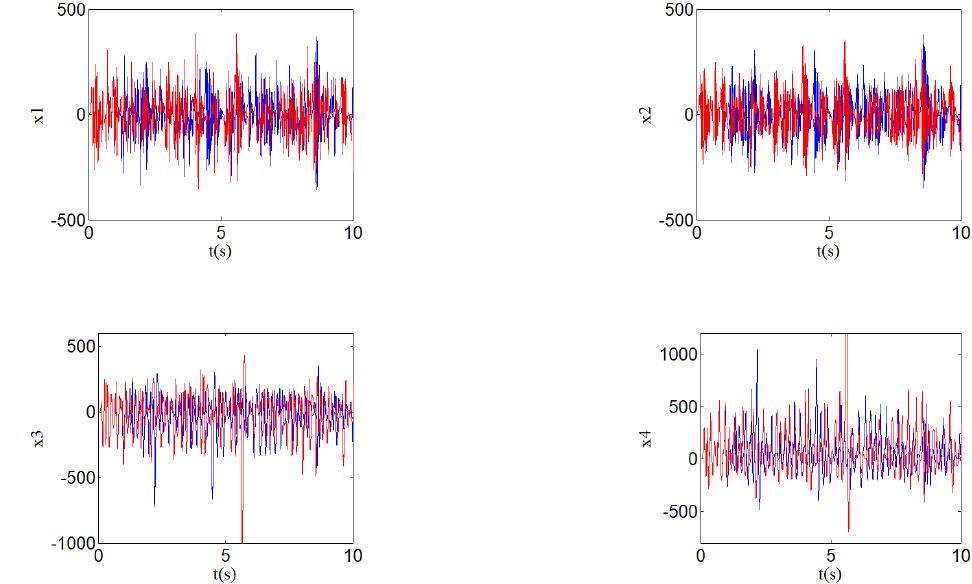
Figure 8. The hyperchaotic system initial value sensitivity with parameters a = 50, b = 26, c = 13, d = 8, e = 33 and f = 30.